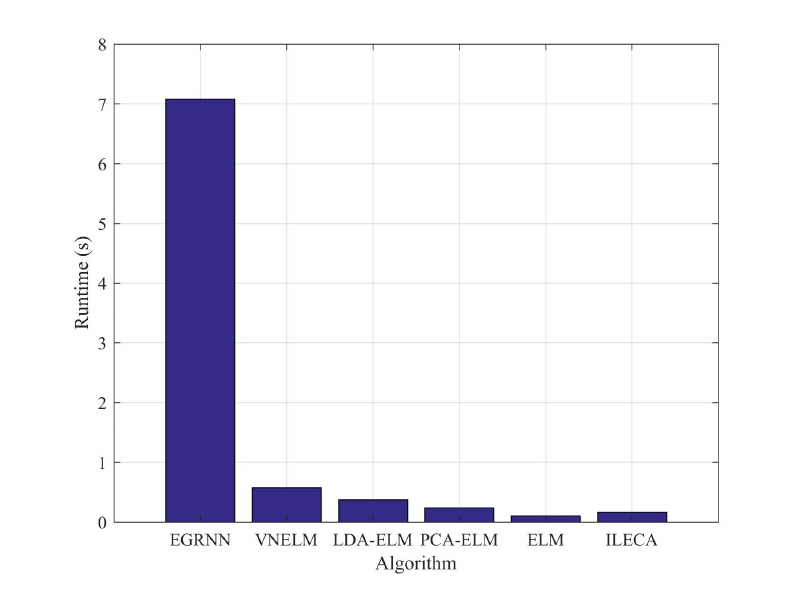
Figure 10. Runtime of